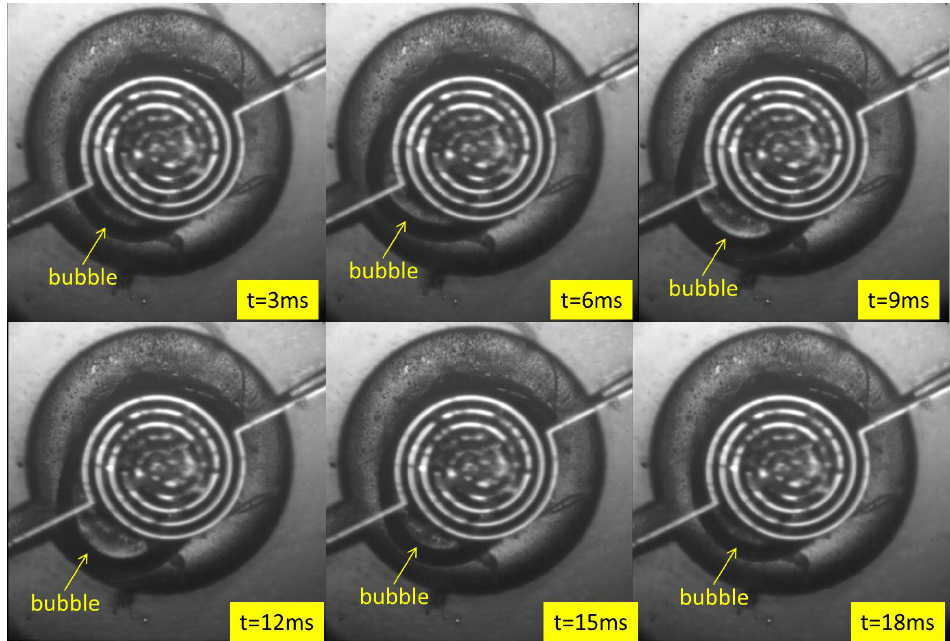
Figure 7. Operation sequence of the bubble actuated micro-pump at a heating frequency of 25 Hz and at a 20% duty cycle (the black arc is the outline of the bubble).